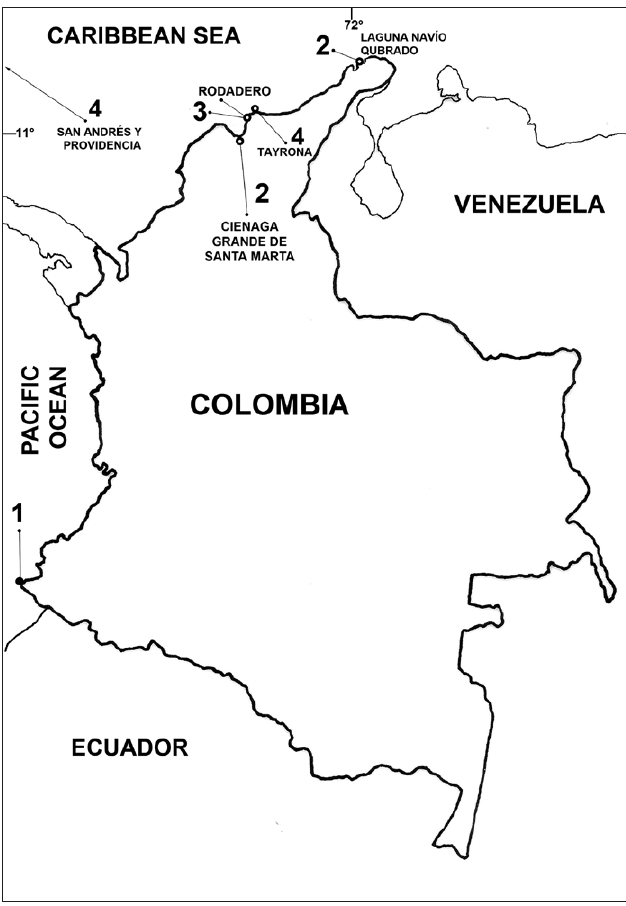
Figure 1 . Distribution of records of Pseudodiaptomus in Colombia. 1.